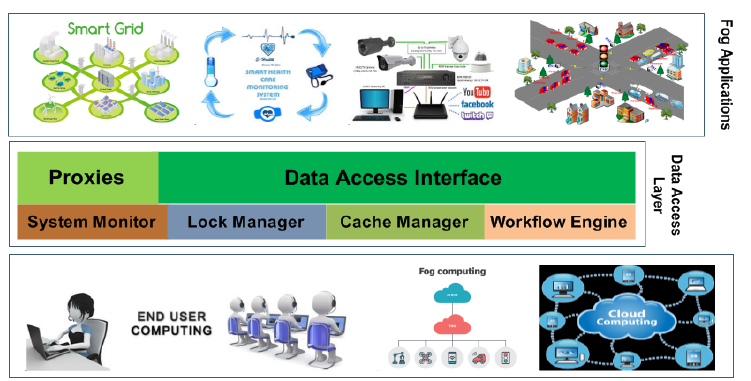
Figure 2. WM-FOG software stack.